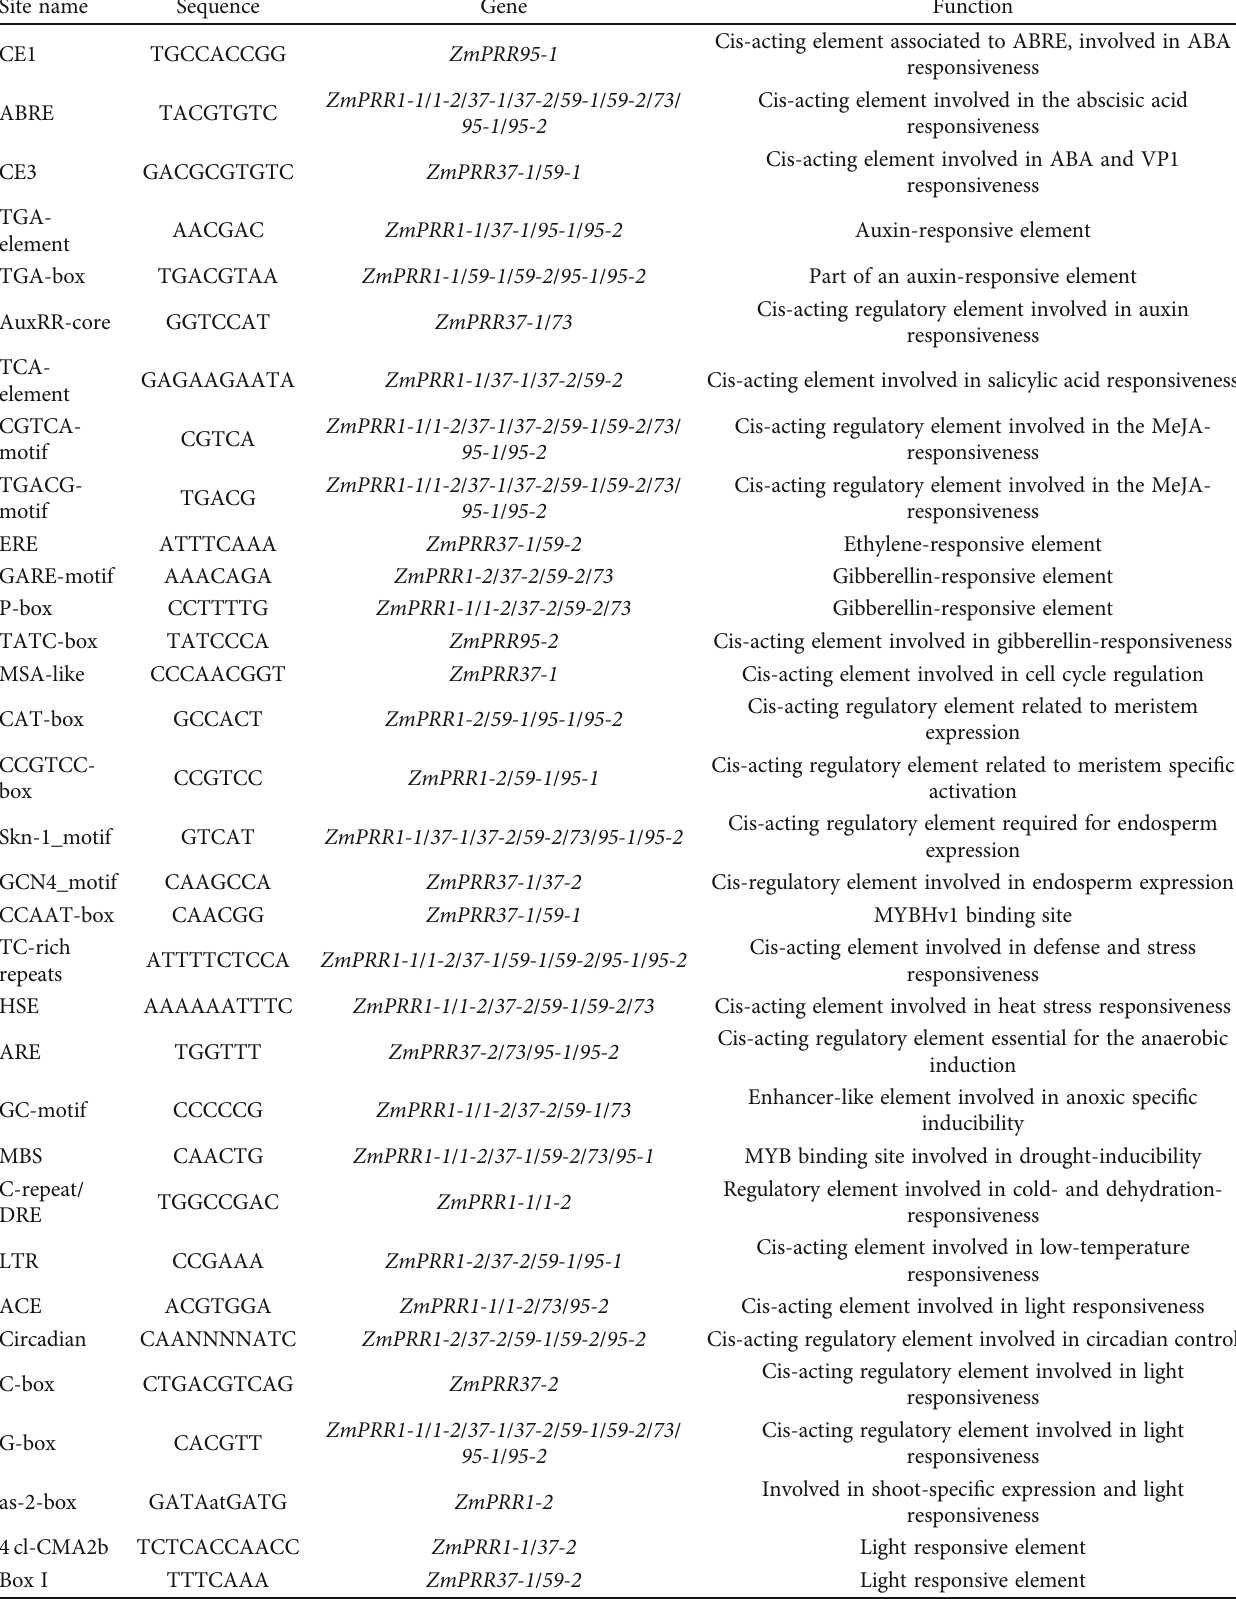
Table 3: Putative cis-elements enriched in the promoters of ZmPRR family